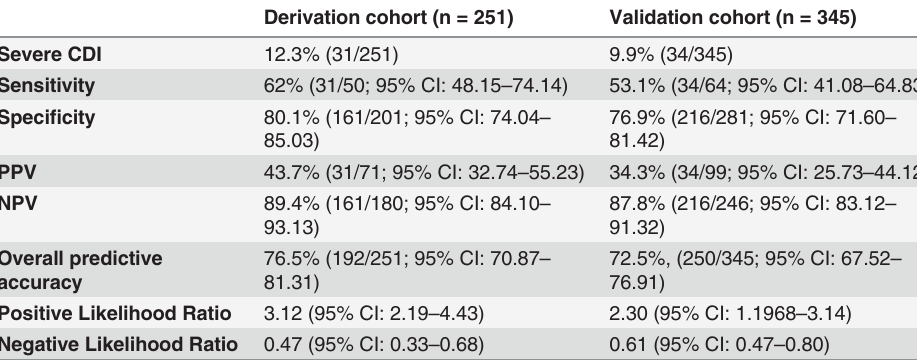
Table 5. Performance Clinical Prediction Score for Severe C . difficile Infection.